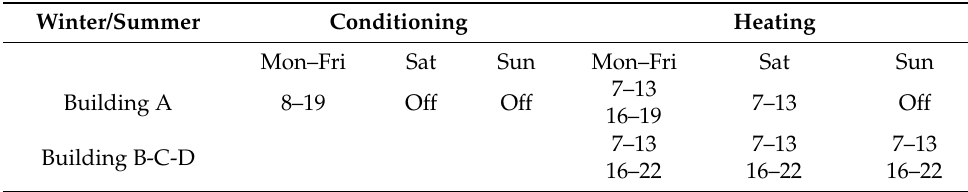
Table 1. Operating hours of heating systems.